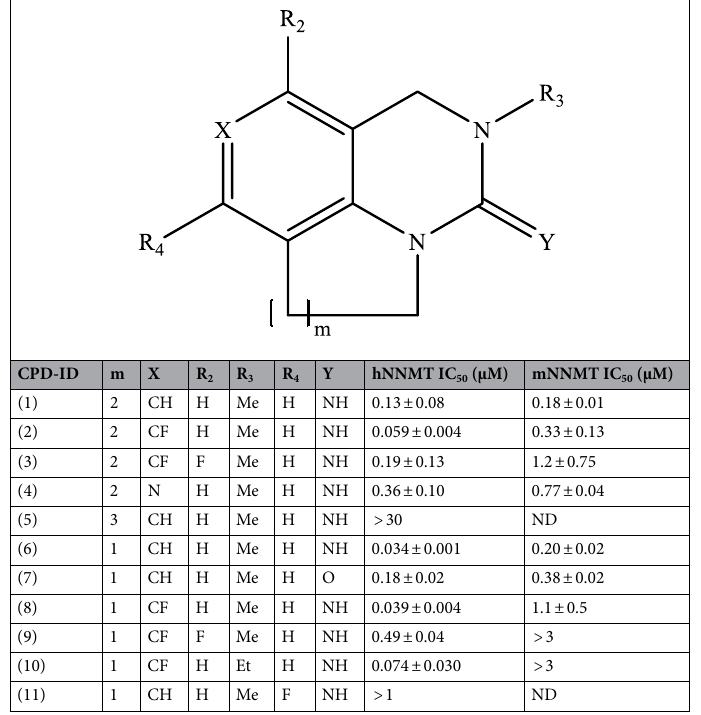
Table 1. SAR of the tricyclic